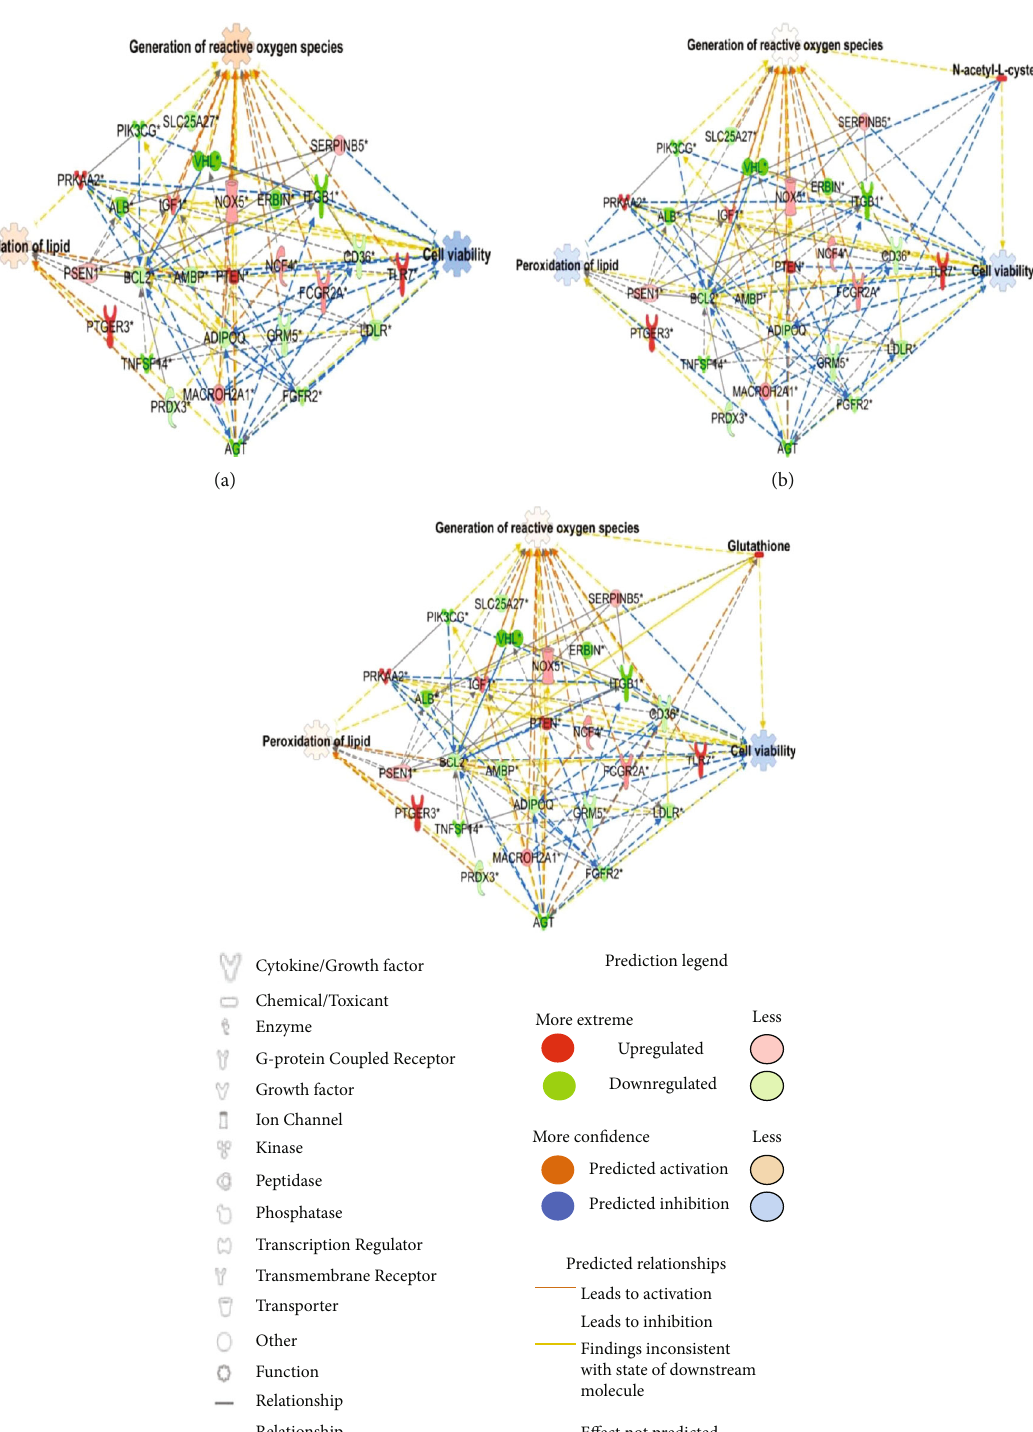
Figure 3: Transcriptomic network related to the quality and freshness of starved human bone marrow-derived mesenchymal stem cells (hBM-MSCs). (a) Analysis of the transcriptomic network with prediction using Ingenuity Pathway Analysis based on starved hBM- MSCs in phosphate-bu ff ered saline for 12 h. Analysis of the transcriptomic network based on a combination of (b) N-acetyl-L-cysteine (NAC) and (c) glutathione (GSH) administered for 12 h. The analysis involved a foldchange cut − off value ± 9 . Green and red nodes indicate genes that were up and downregulated, respectively, compared to control levels. Orange and blue arrows indicate in silico prediction of function as activation and inhibition, respectively. Details of the shape and color, which were created with Ingenuity Systems (http://www.ingenuity.com), are described in the